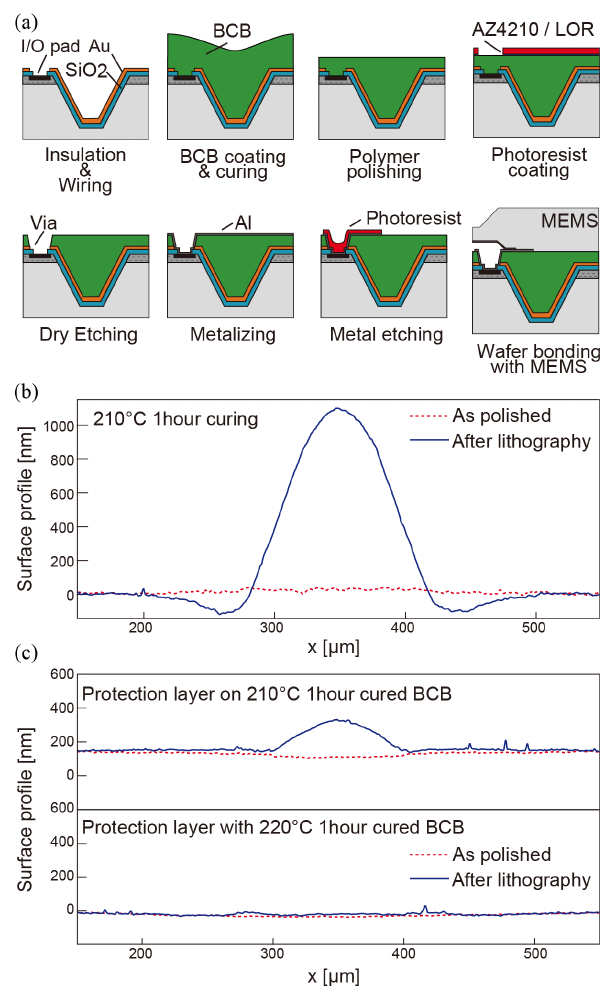
Figure 5. Filling of grooves with BCB and anti-swelling layer: ( a ) procedure of TSG forming; ( b ) swelling at groove due to swelling of BCB; ( c ) suppression of swelling by anti-swelling layer.